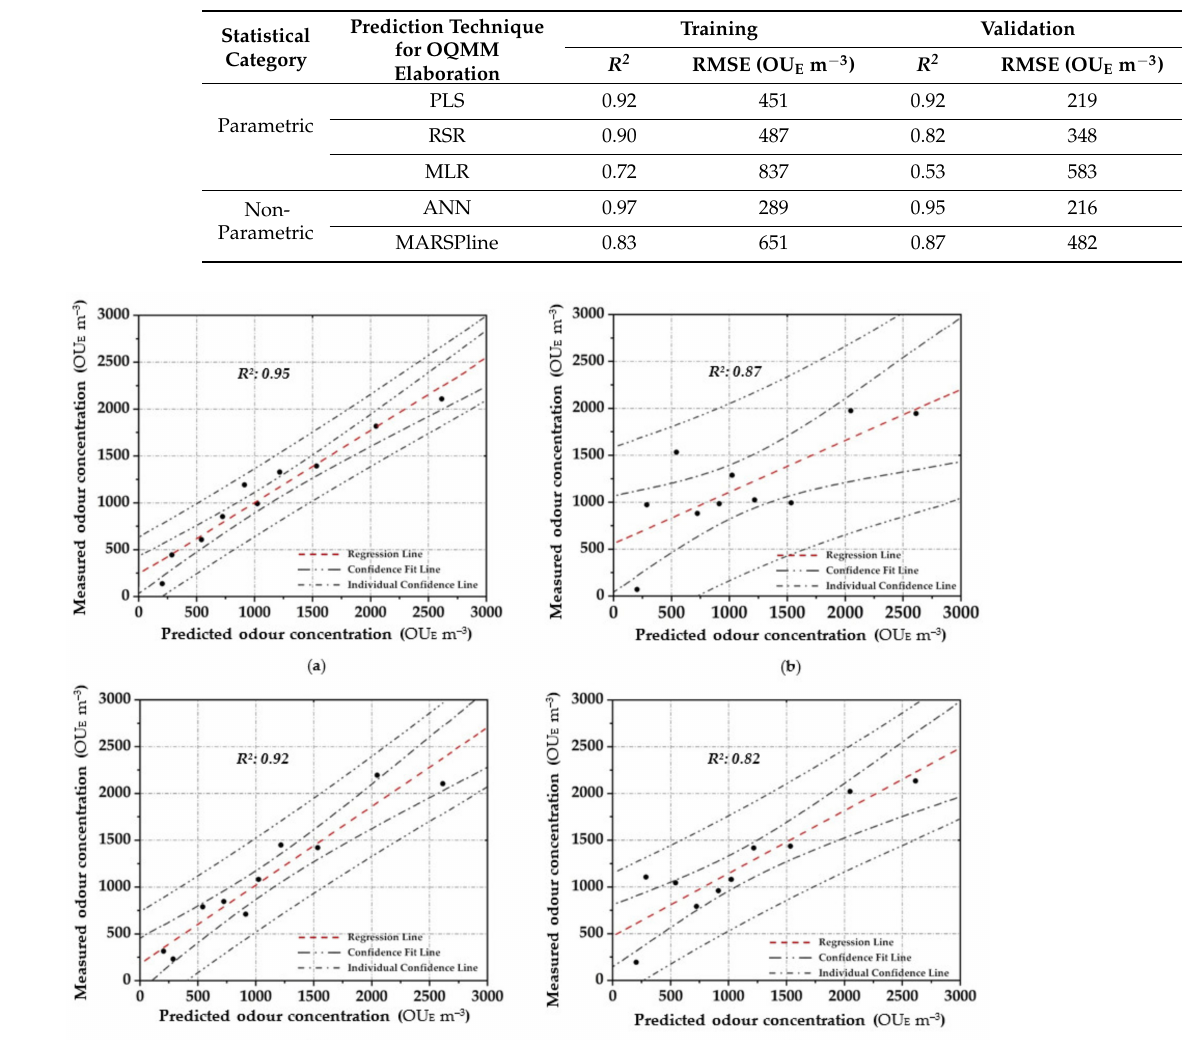
Table 4. Summary of the quality parameters of the developed model during training and validation.